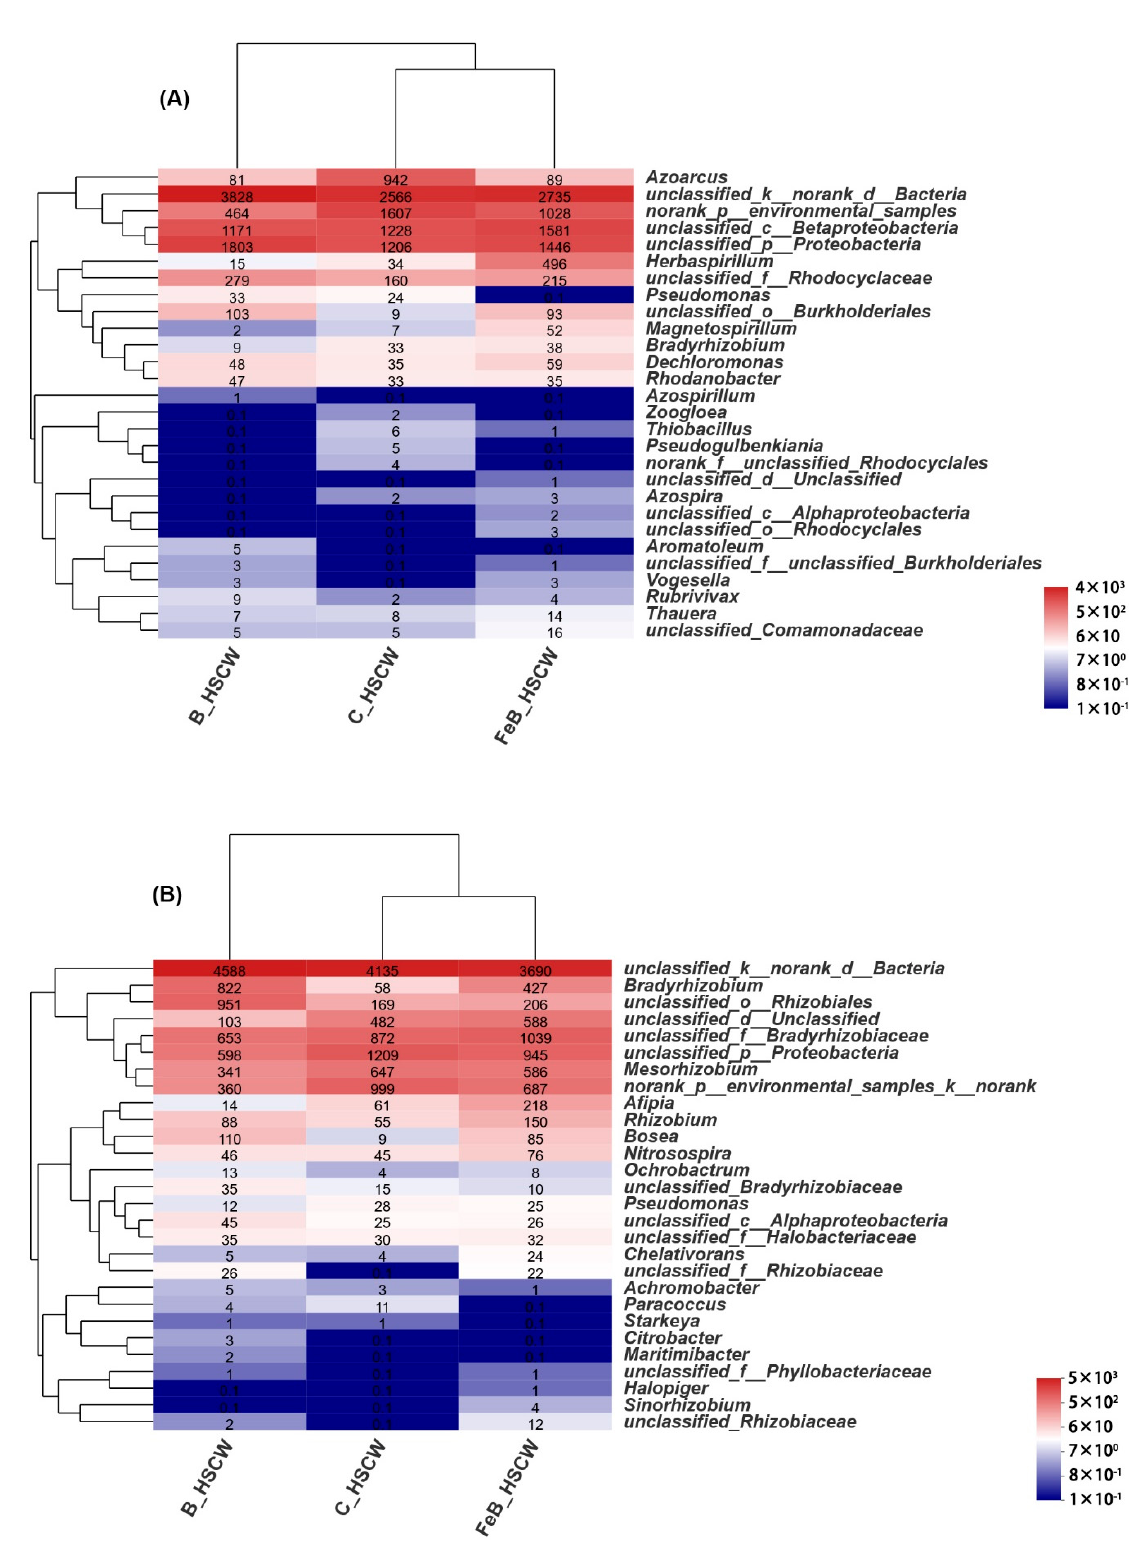
Figure 3. The community structures of nirS -denitrifiers ( A ) and nirK -denitrifiers ( B ) at the genera level ( A ) in the three constructed wetlands (HSCWs; heat map of hierarchy cluster for the top 50 genera). C-HSCW, without biochar and FeB-modified biochar; B-HSCW, with biochar; FeB-HSCW, with FeB-modified biochar.